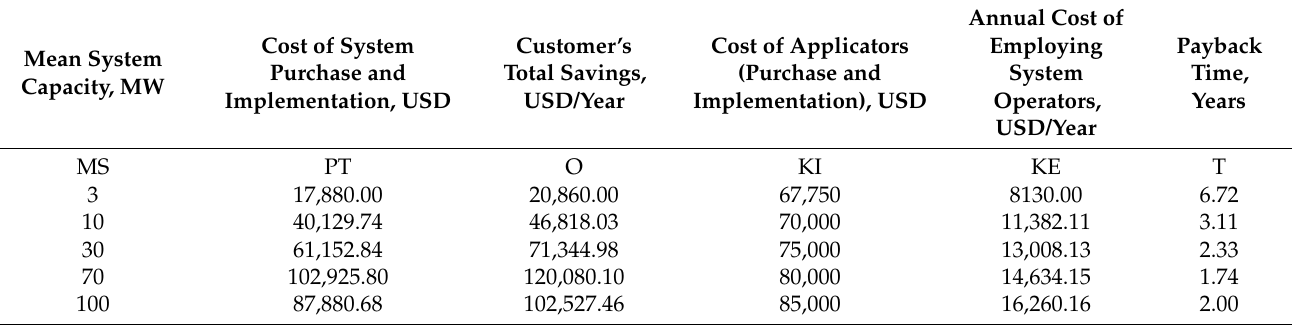
Table 9. Calculation of the system user’s